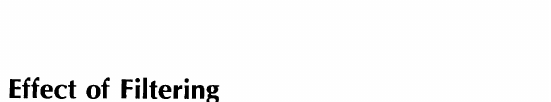
Table 17. UMTRI Frontal Pendulum Tests with Cadaveric SUbjects Test Test Signals